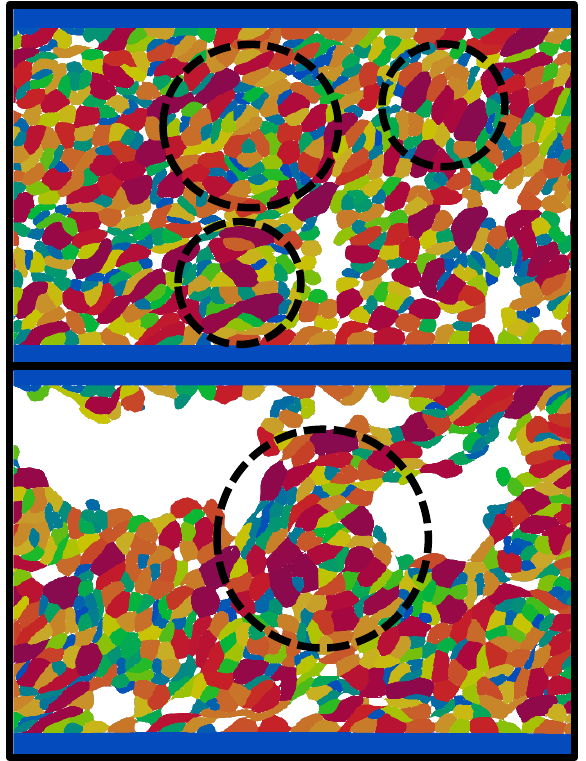
Fig. 3. View of two simulations, with formation of agglomerates. From top to bottom: small agglomerates (cohesion between particles of 2.2 GPa), and large agglo- merates (4 GPa). The Young’s modulus is 1.6 GPa for all simulations.